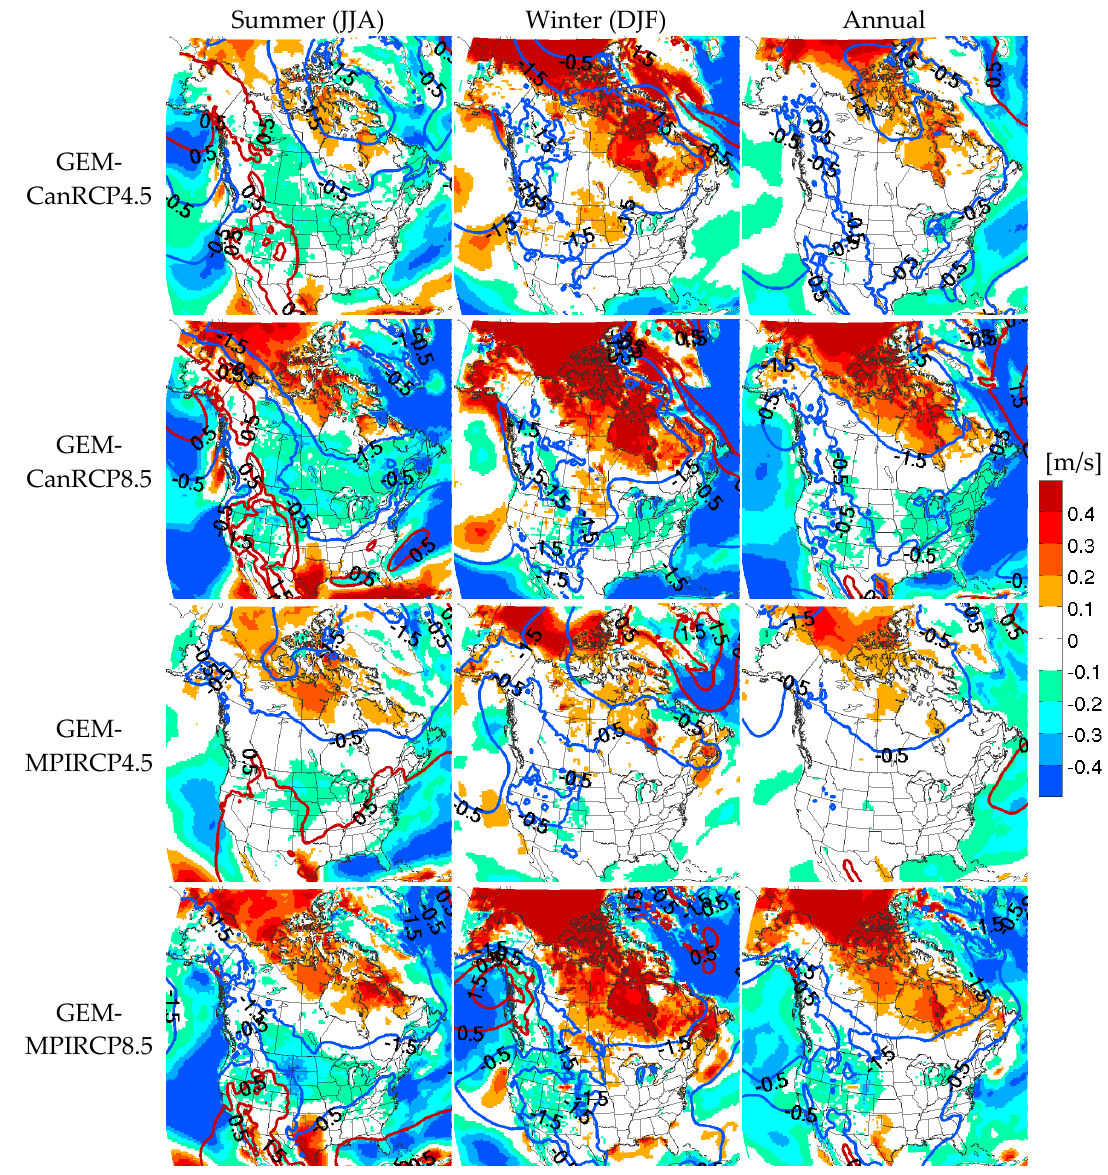
Figure 4. Projected changes to summer, winter, and annual mean wind speeds (legend) for the future 2071–2100 period relative to the current 1981–2010 period. Projected changes to mean sea-level pressure (MSLP, unit: hPa) are represented by red (for increases) and blue (for decreases) contours.